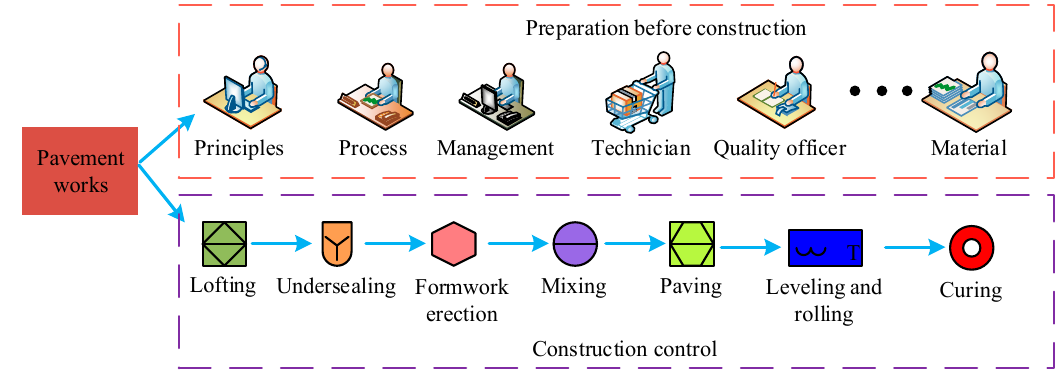
Figure 2. Construction process of pervious road payment works.